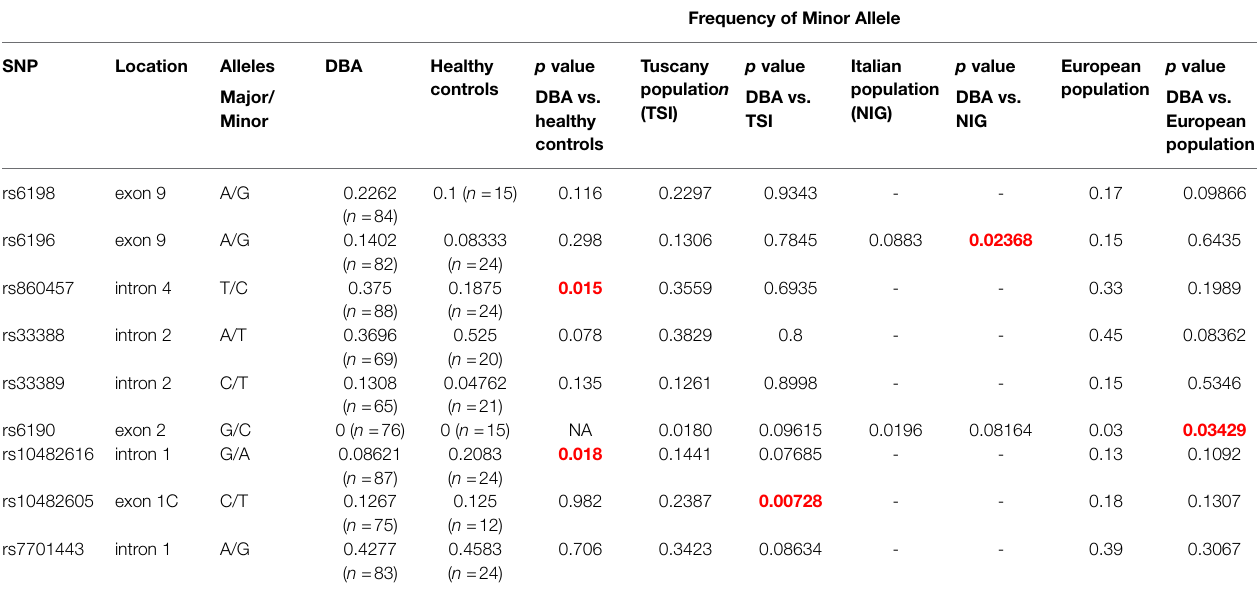
TABLE 2 | Summary of the single nucleotide polymorphisms (SNPs) investigated and of their frequency in the DBA population, in healthy controls and in publicly available data bases of the Italian and European